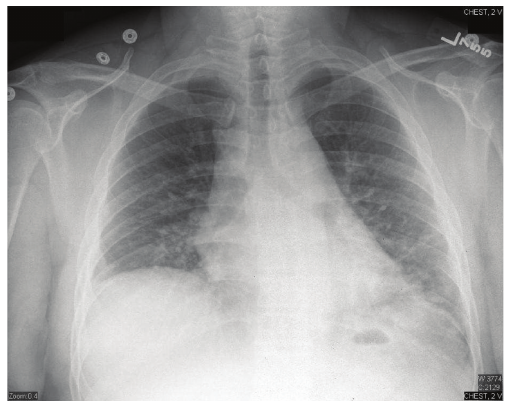
Figure 1: Chest X-ray on day 14 after chemotherapy (ANC was less than 100 cell/ µ L).